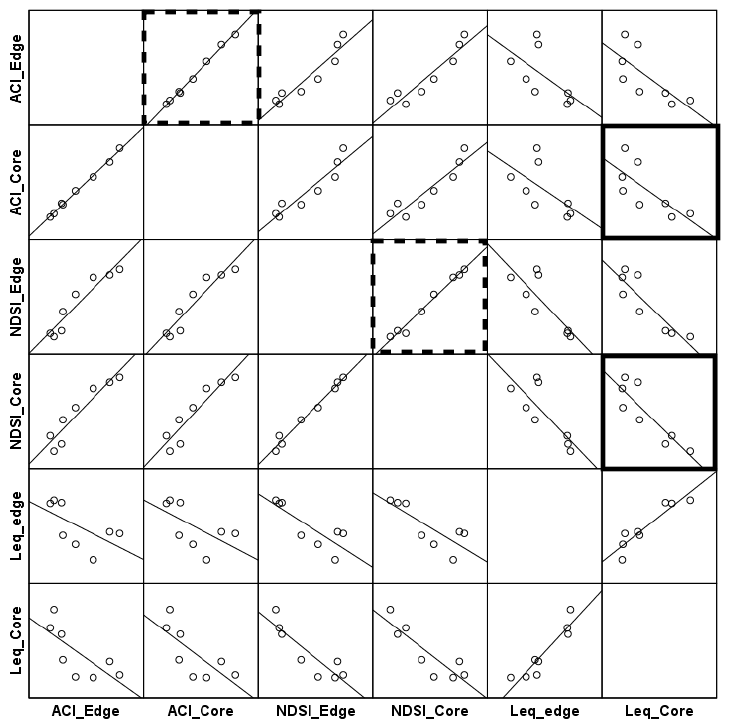
Figure 1. The correlation matrix highlighting several negative correlations and several positive correlations represented in dashed border lines.